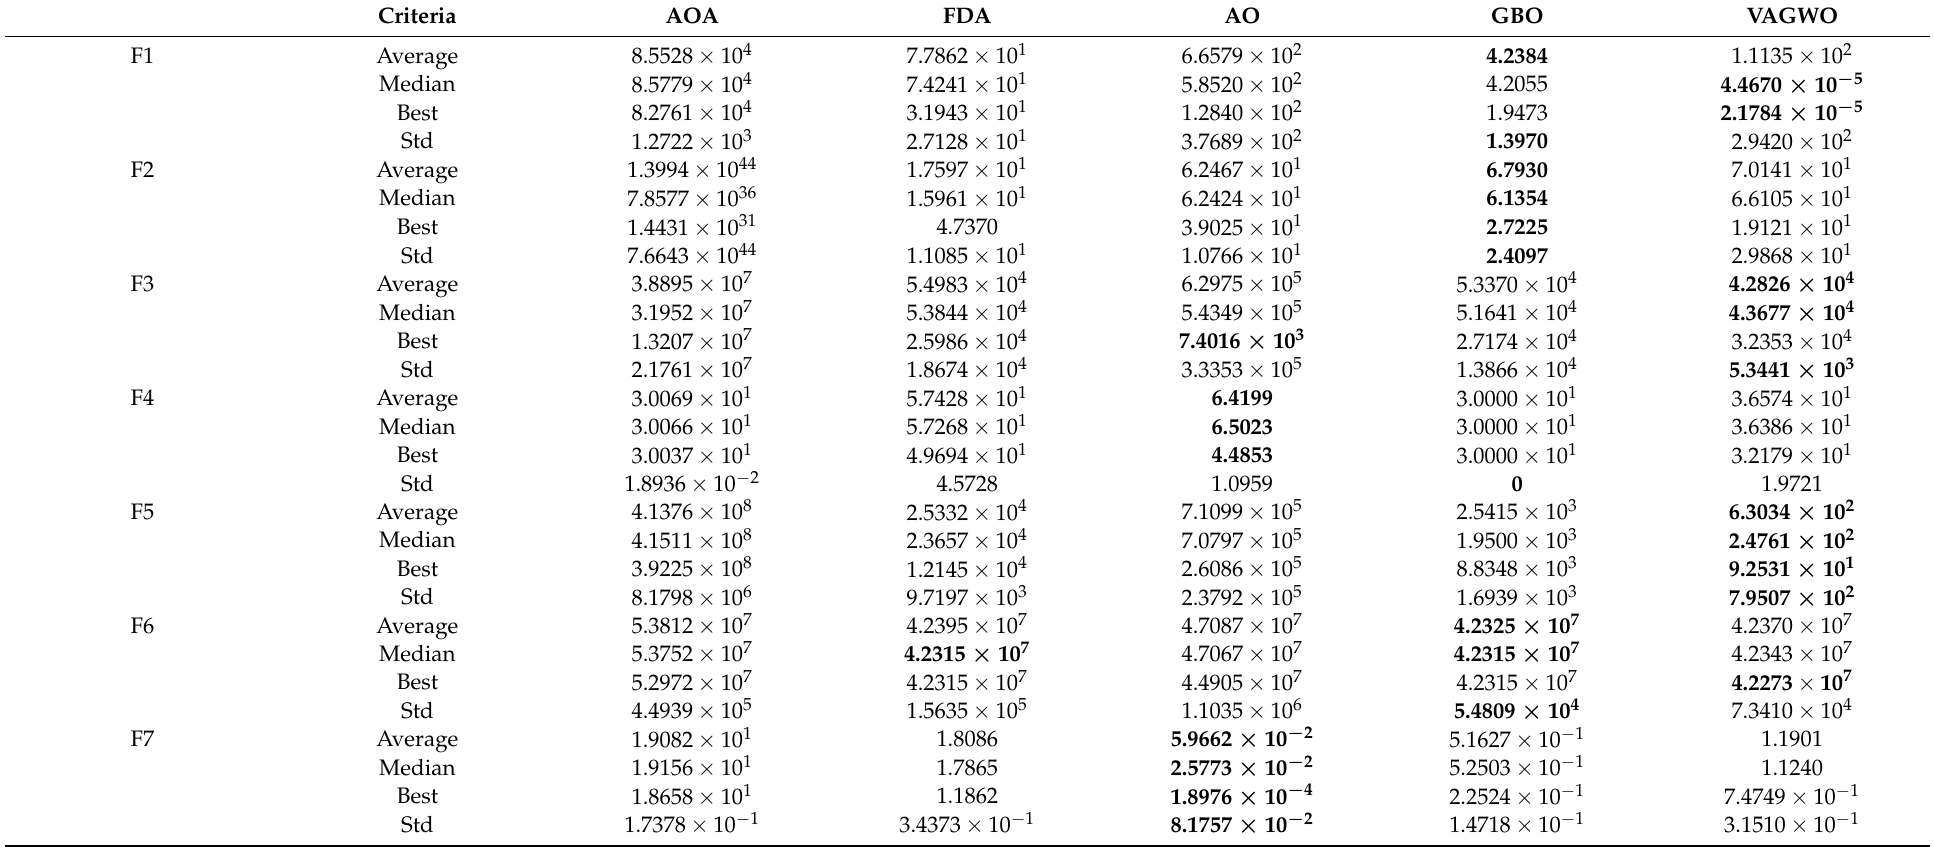
Table 6. The results achieved by the VAGWO against the newly proposed algorithms for the uni-modal functions at D = 100.